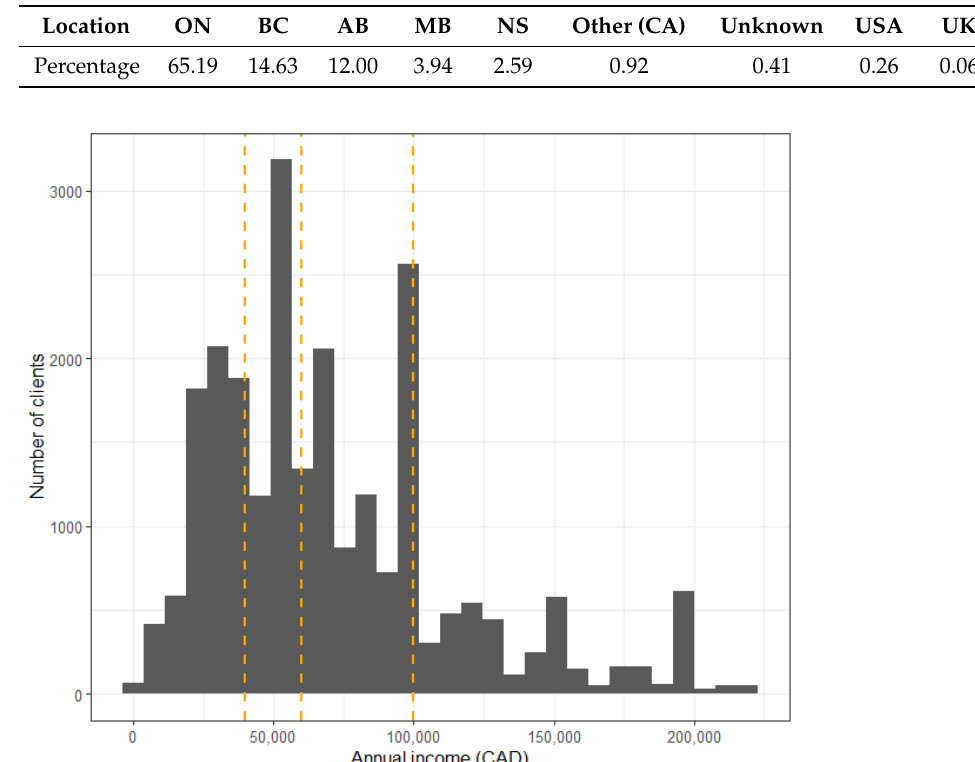
Figure 2. Distribution of client ages, where each bin contains one year. Table 2. Distribution of residency for client accounts. Locations are Ontario (ON), British Columbia (BC), Alberta (AB), Nova Scotia (NS), Canada (CA), United States of America (USA), United King- dom (UK).